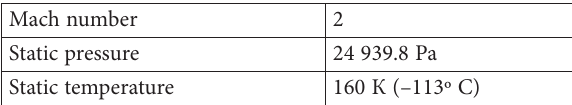
Table 1. Flow parameters in the WT working